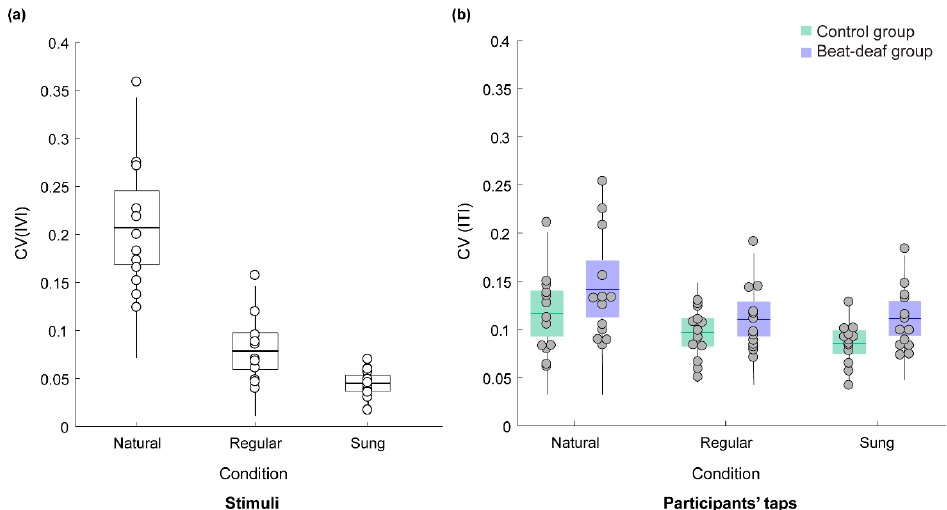
Figure 3. (a) Coefficient of variation (CV) of the intervocalic interval (IVI) between stressed syllables of the stimuli. Each dot represents a sentence. (b) Mean CV of the inter-tap interval (ITI) produced by the beat-deaf and control group as a function of sentence type. Each dot represents a participant. Boxes correspond to a 95% confidence interval from the mean based on the standard error of the mean (SEM). The darker horizontal line within each box indicates the group mean, while the vertical lines represent two standard deviations from the mean.